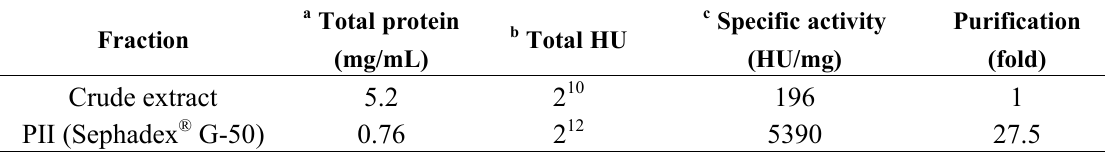
Table 2. Purification of lectin from Dioclea lasiophylla seeds.